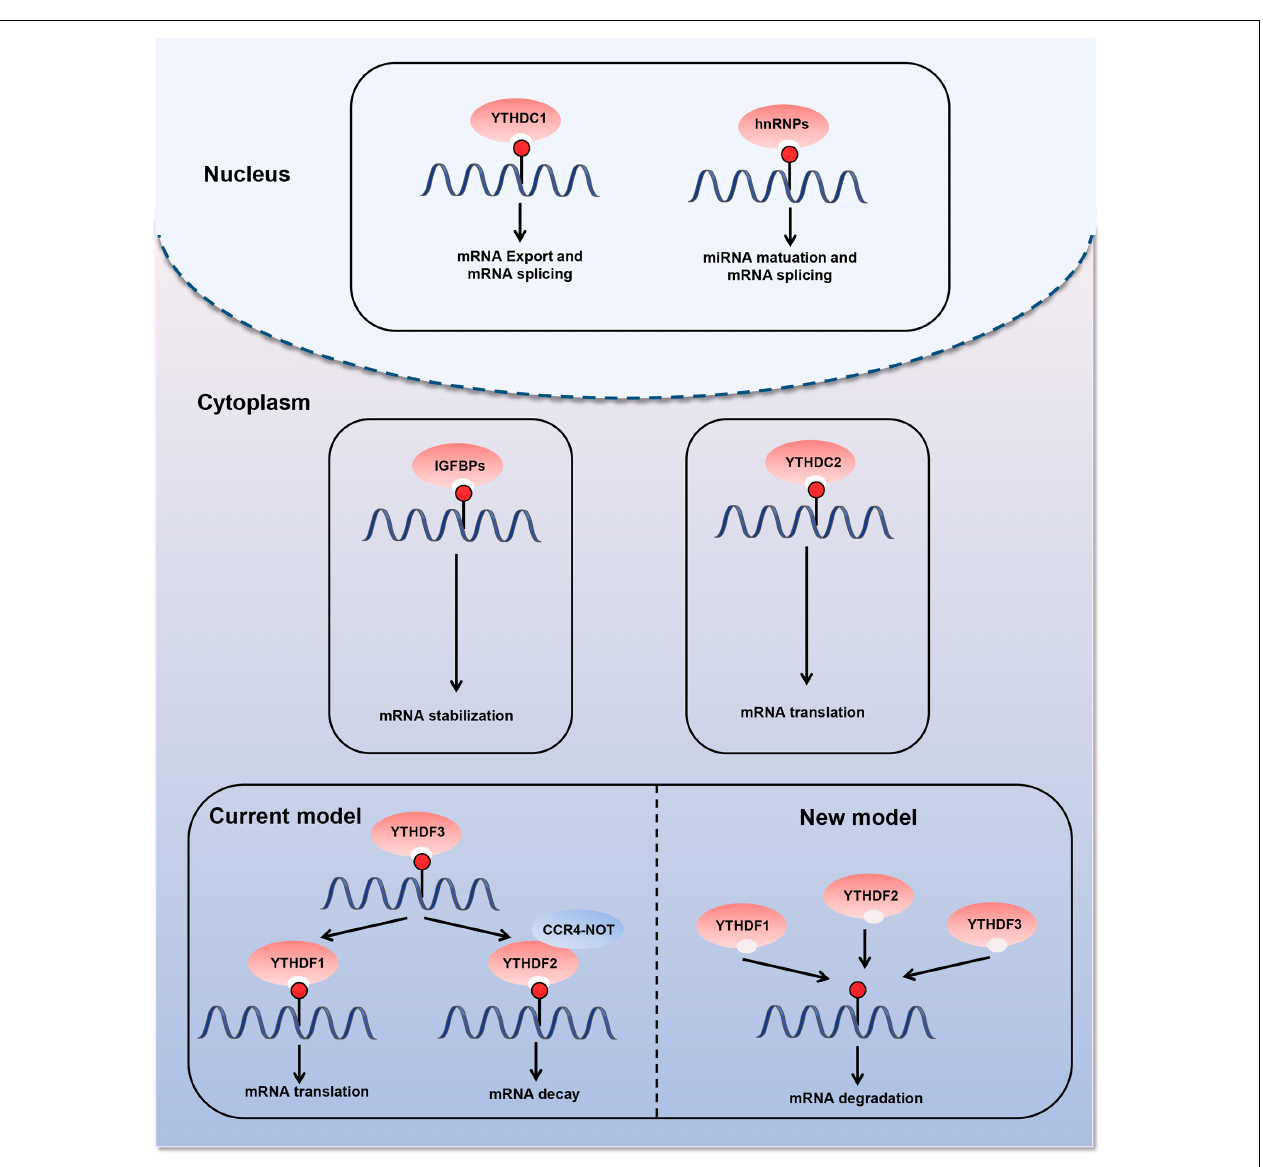
FIGURE 2 | Diverse biological consequences of m6A methylation by different m6A “readers.” m6A “readers” can recognize and bind to the m6A modification sites in RNA. They play an important role in different biological functions. The first m6A "readers" identified were YTHDF1, YTHDF2, YTHDF3, YTHDC1, and YTHDC2, which contain a conserved YTH domain (YT521-B homology). Moreover, three heterogeneous nuclear ribonucleoproteins (hnRNPs) are common “readers,” namely hnRNPC, hnRNPG, and hnRNPA2B1. m6A “readers” are involved in various steps of RNA metabolism, including pre-mRNA splicing, mRNA translation, nuclear export, and mRNA